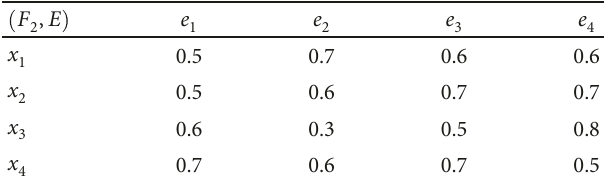
Table 12: The evaluation value of expert 2.